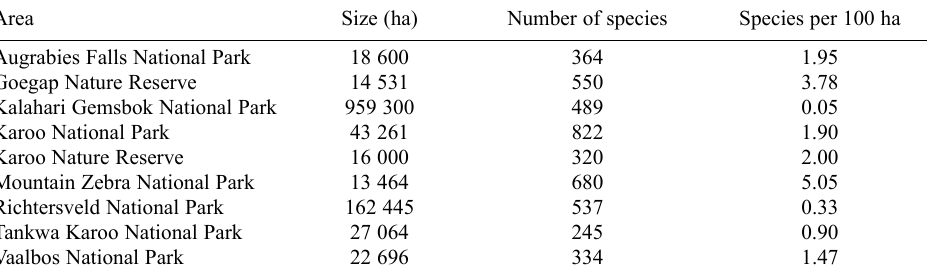
Comparison of the species/area ratio of selected protected areas in South Africa Area Size